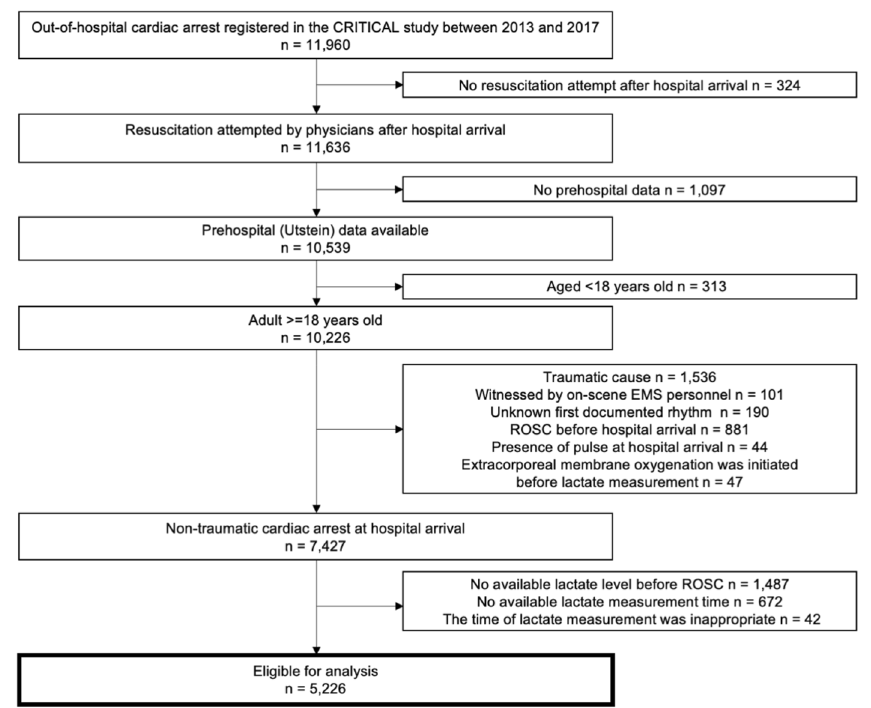
Figure 1. Overview of out-of-hospital cardiac arrests from 2013 to 2017 in the CRITICAL study. EMS emergency medical service, OHCA out-of-hospital cardiac arrest, ROSC return of spontaneous